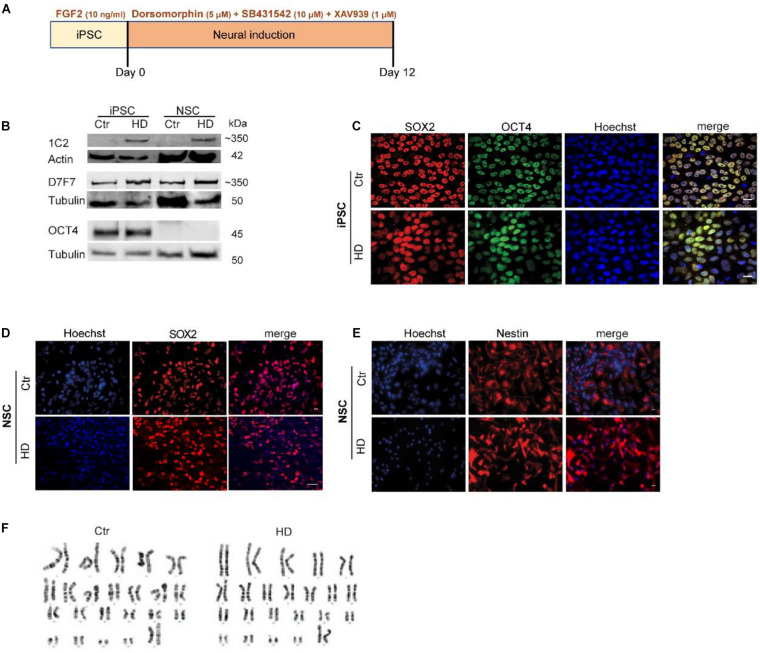
Characterization of HD and Control-iPSC and NSC Lines. (A) Scheme of neural differentiation protocol based on dual SMAD inhibition. (B) Western blots of HTT protein expression in iPSC and iPSC-derived NSC with the HTT antibody 1C2 (polyglutamine stretch) and D7F7 (residues surrounding Pro1220) demonstrate normal and mutant HTT expression, respectively. The pluripotency marker OCT4 is shown in iPSC only. (C) Expression of pluripotency markers OCT4 and SOX2 in iPSC. (D,E) Expression of neural stem cell markers SOX2 and Nestin, respectively. Scale bar (in panel C,E) indicates 50 μm. (F) Karyotyping and g-band analysis show that iPSC lines have a normal 46,XX karyotype.